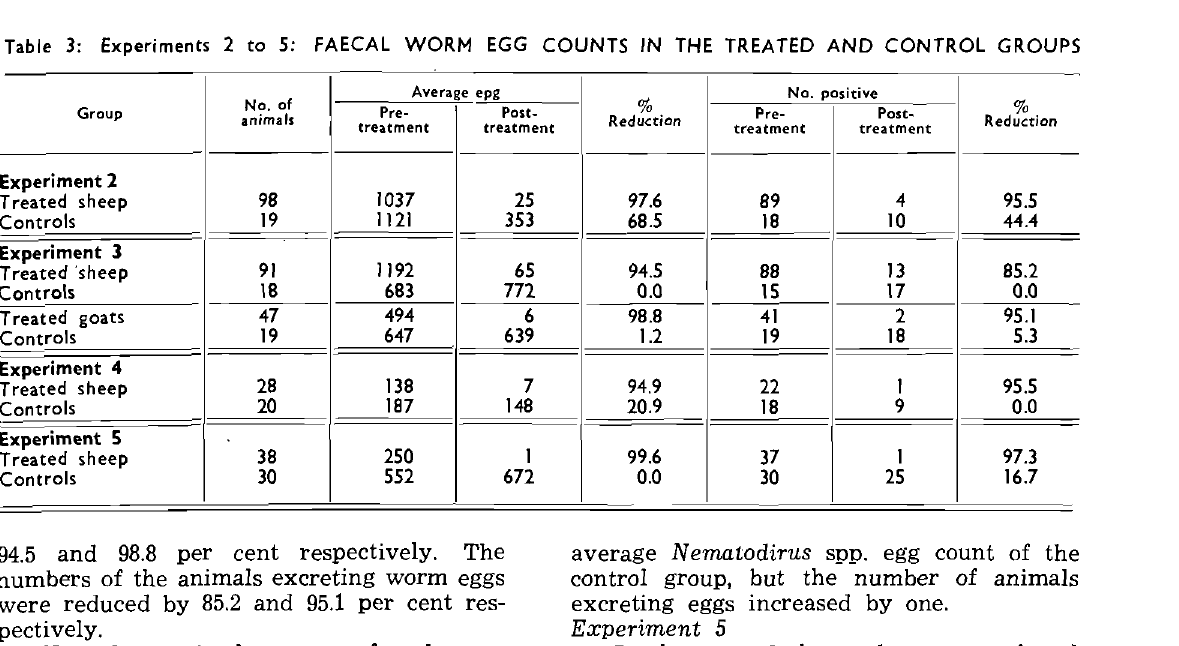
Table 4: Experiment 6: FAECAL WORM EGG COUNTS IN THE TREATED, UNTREATED AND NATURALLY